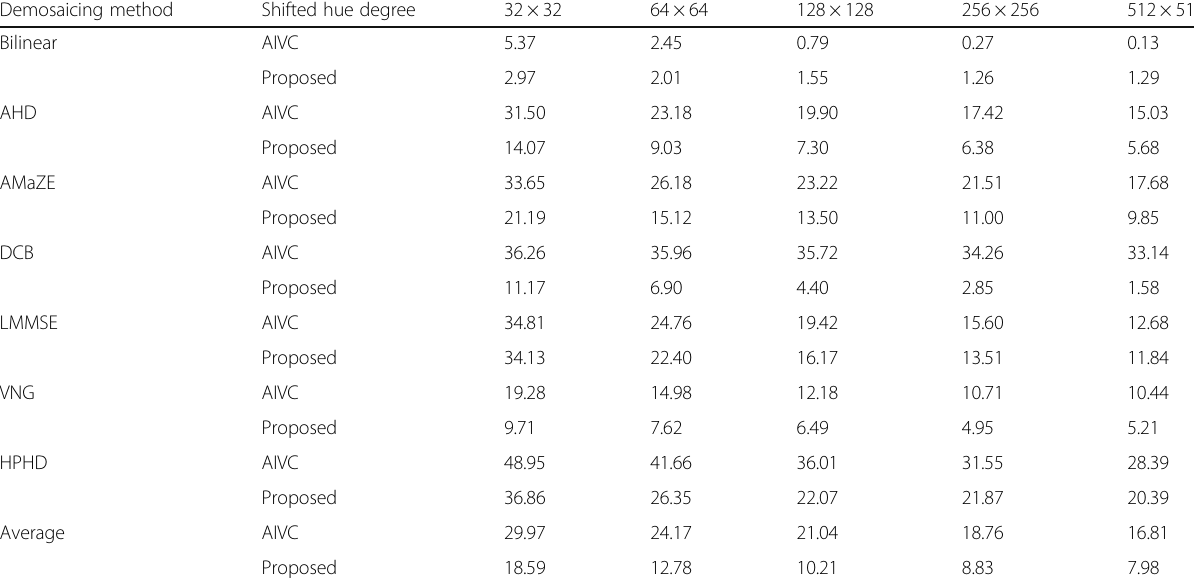
Table 4 Mean error value comparison between AIVC and the proposed method for various demosaicing methods and centered blocks with a shifted angle of 45° Demosaicing